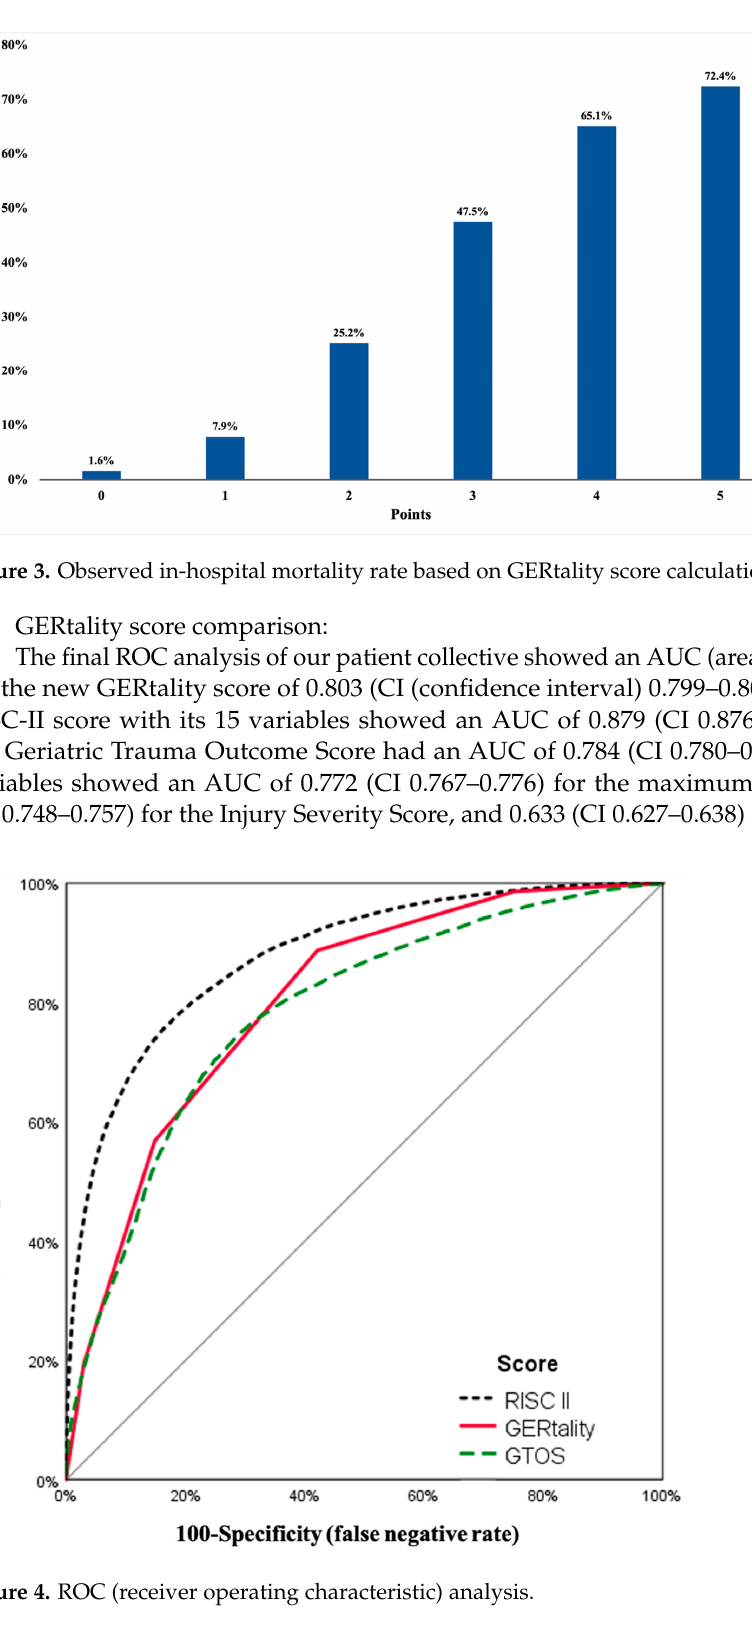
Figure 2. Relevant variables for the GERtality score. ASA, American Society of Anesthesiologists, GCS, Glasgow Coma Scale. The maximum GERtality score showed an in-hospital mortality rate of 72.4% com- pared to 65.1% with patients scoring 4 points on the GERtality score and 47.5% with a total score of 3 points. The mortality with a score of 0 was 1.6% (Figure 3).